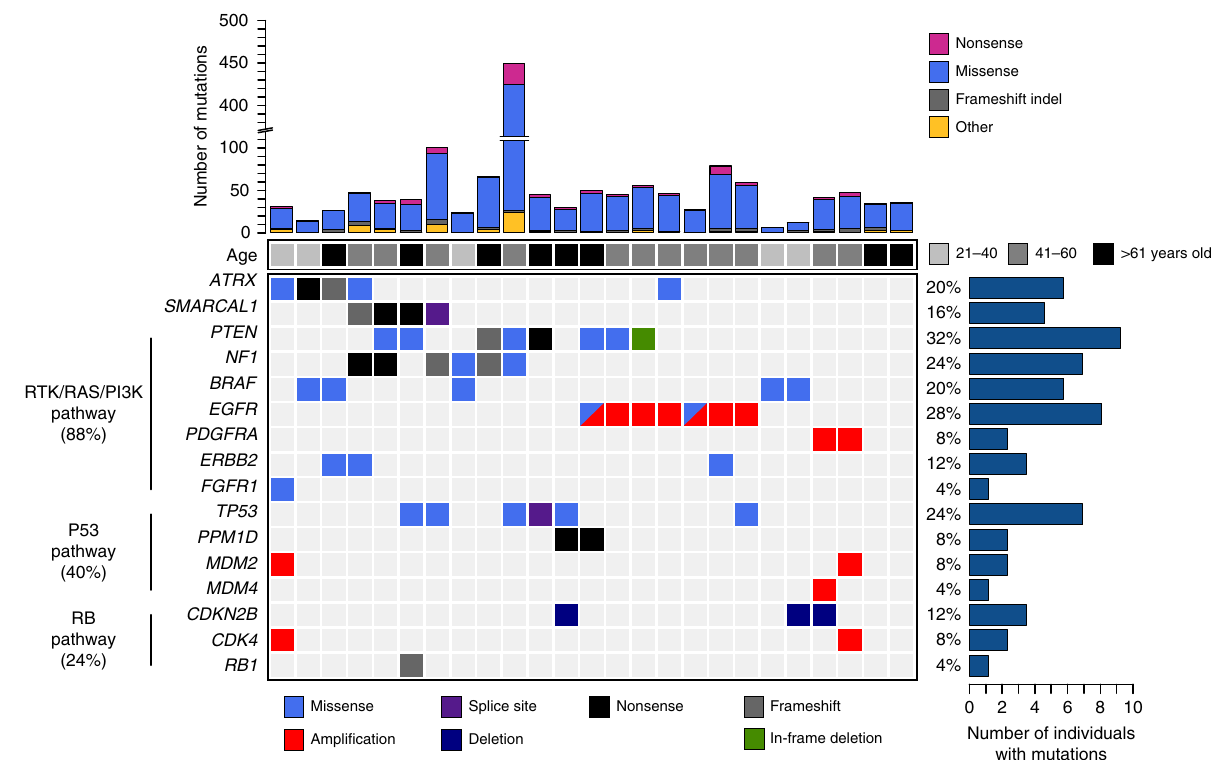
Fig. 1 The mutational landscape of somatic coding alterations in TERTp WT -IDH WT GBM. Whole exome sequencing was performed on TERTp WT -IDH WT GBMs ( N = 25). Recurrently mutated pathways identi fi ed included the RTK/RAS/PI3K (88%), P53 (40%), and RB (24%) pathways. Somatic mutation rates per case are shown with corresponding patient age (top). Recurrently mutated genes displayed determined to be signi fi cantly mutated (IntOgen algorithm, P < 0.05, n ≥ 2) are shown, as well as select lower frequency genes that are recurrently mutated in glioma or known oncogenes/tumor suppressors in the pathways shown. The mutation frequency of each gene is shown (right) as a percentage of the total